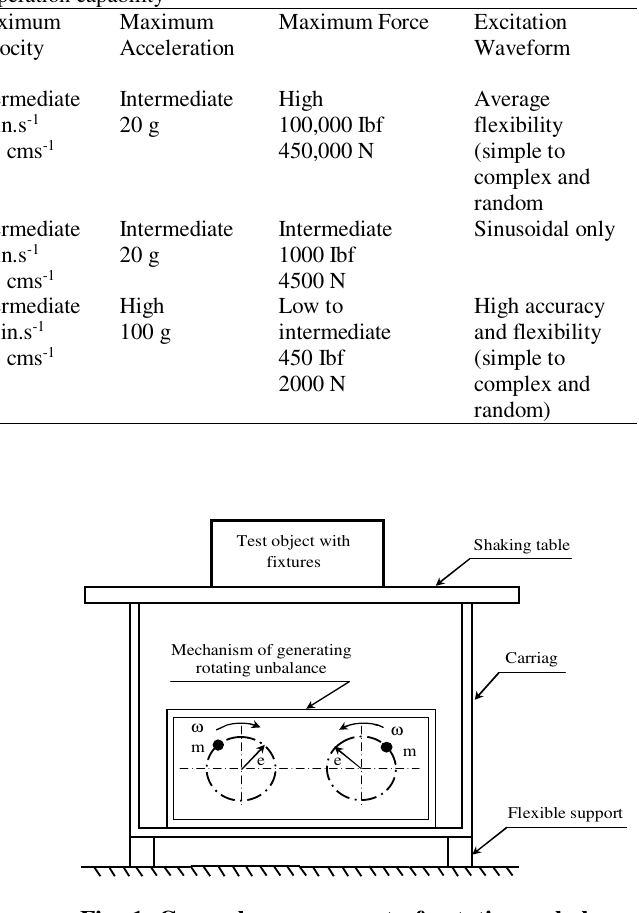
Fig. 1. General arrangement of rotating unbalance vibration